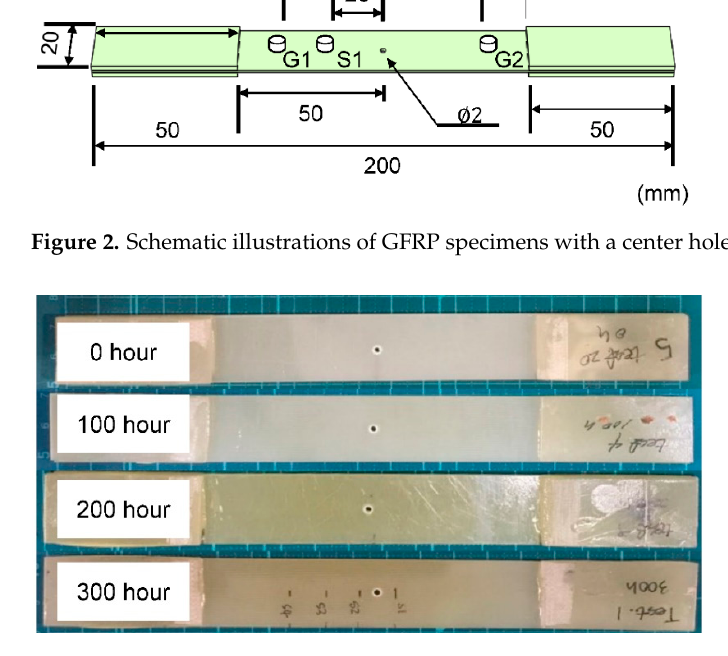
Figure 3. GFRP specimens after UV irradiation.